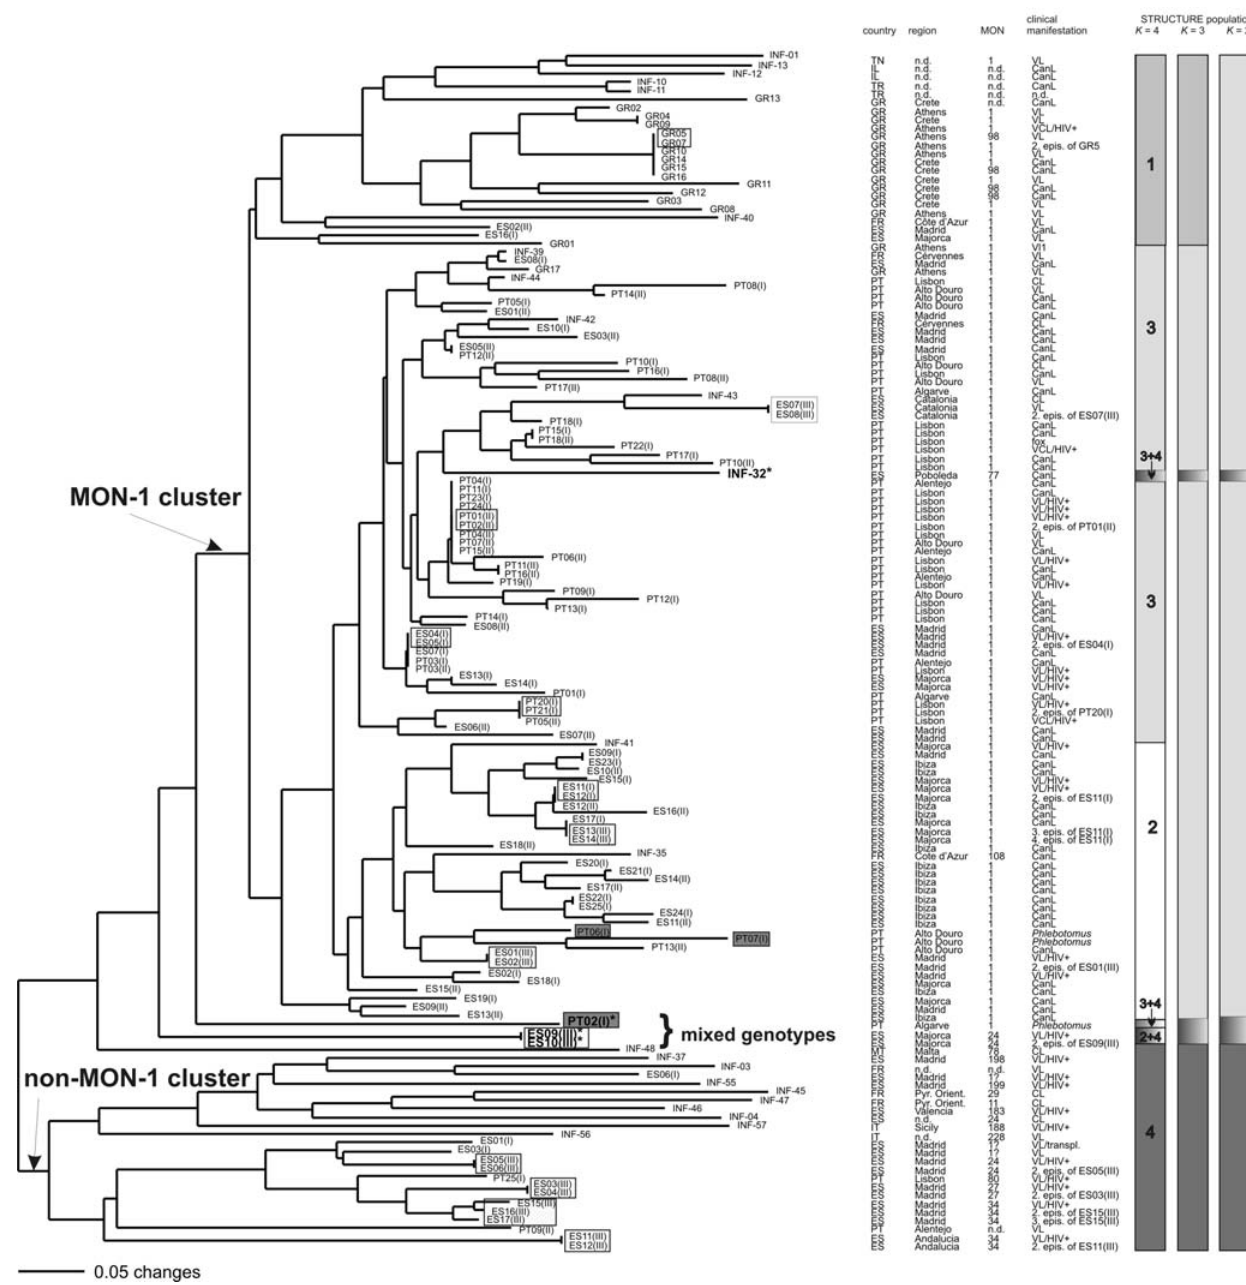
Figure 2. Neighbor-joining tree inferred from Dps-distances calculated for the data of 14 microsatellite markers and all 141 L. infantum strains. Geographical origins, zymodemes and clinical manifestation are shown. Phlebotomus strains are marked by grey rectangles, relapses by white rectangles. Four strains with mixed MON-1/non-MON-1 ancestry are marked by an asterix. Populations as inferred by STRUCTURE K =2, K =3 and K =4 are indicated by bars in different colors next to the tree. Midpoint rooting was applied for the NJ tree, no outgroup has been used.